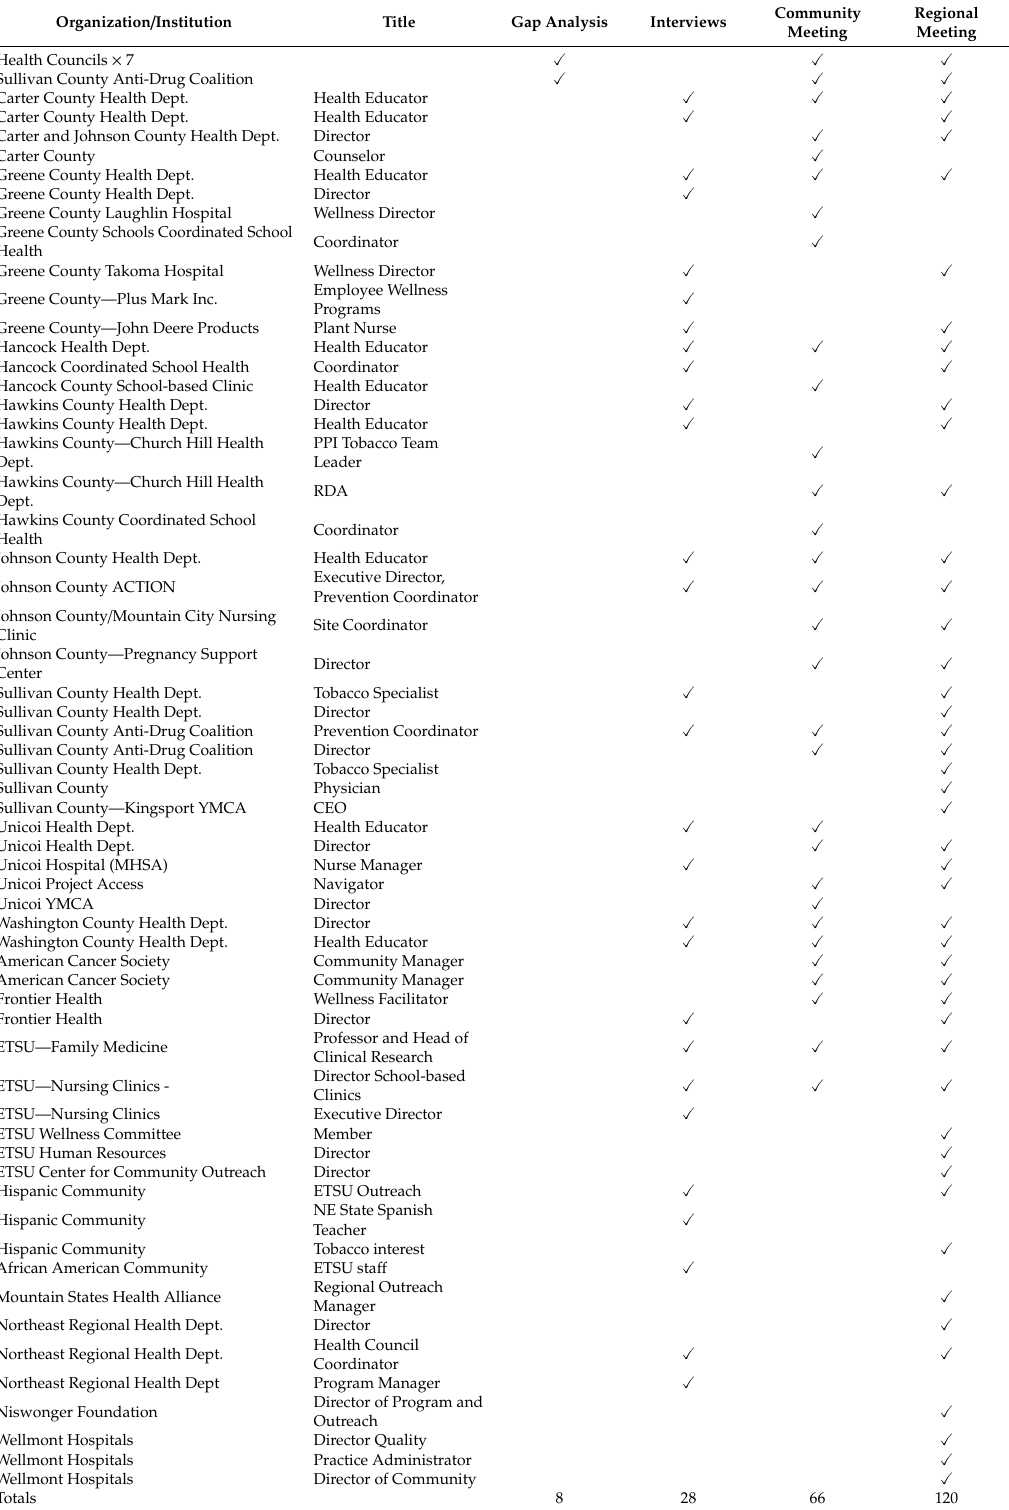
Table 1. Stakeholders for PHIP Tobacco Control project in Northeast